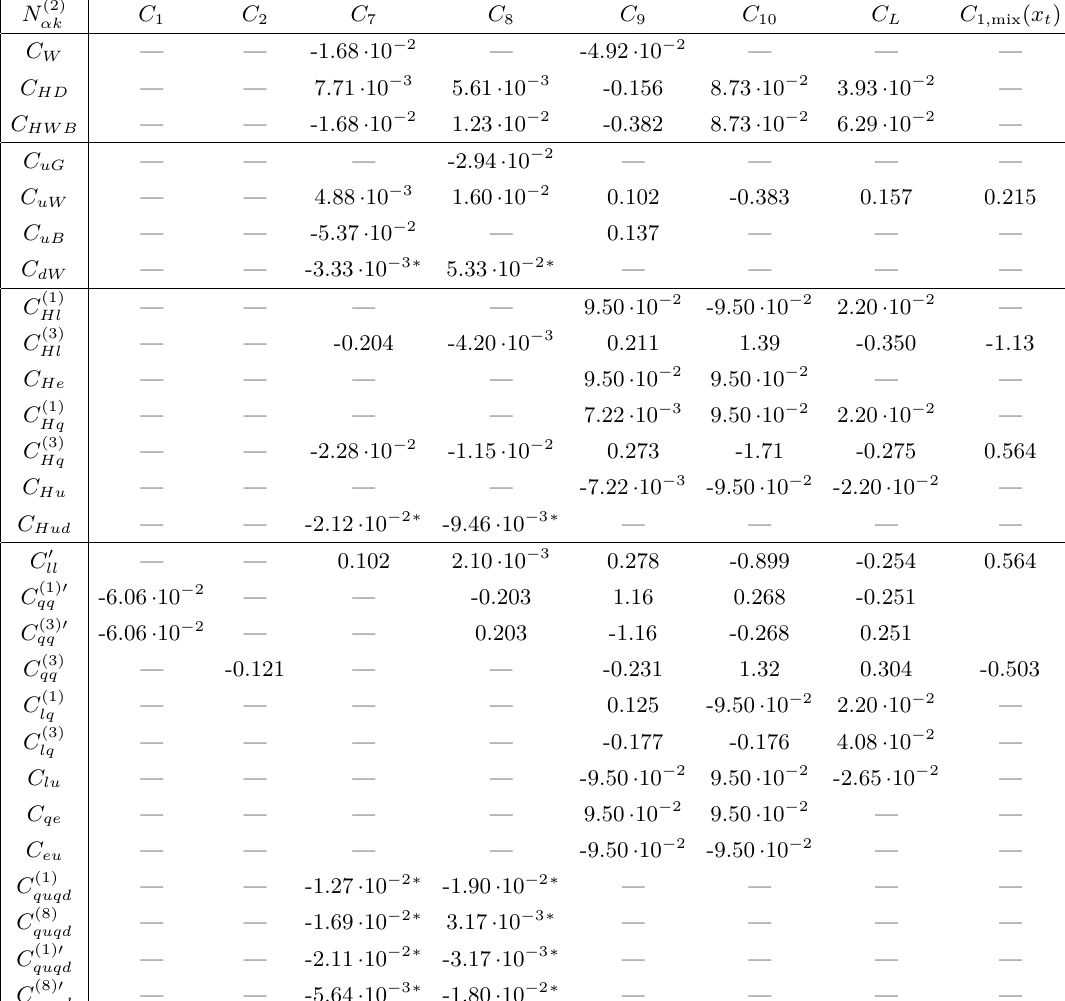
Table 5. Numerical values of the coefficients N (2) { α em , m Z , G F } input scheme. All results are quark-flavour universal ( C α ≡ C bs except for results indicated by an asterisk ( ∗ ), for which only C bd j α is meant ( d j = s, d